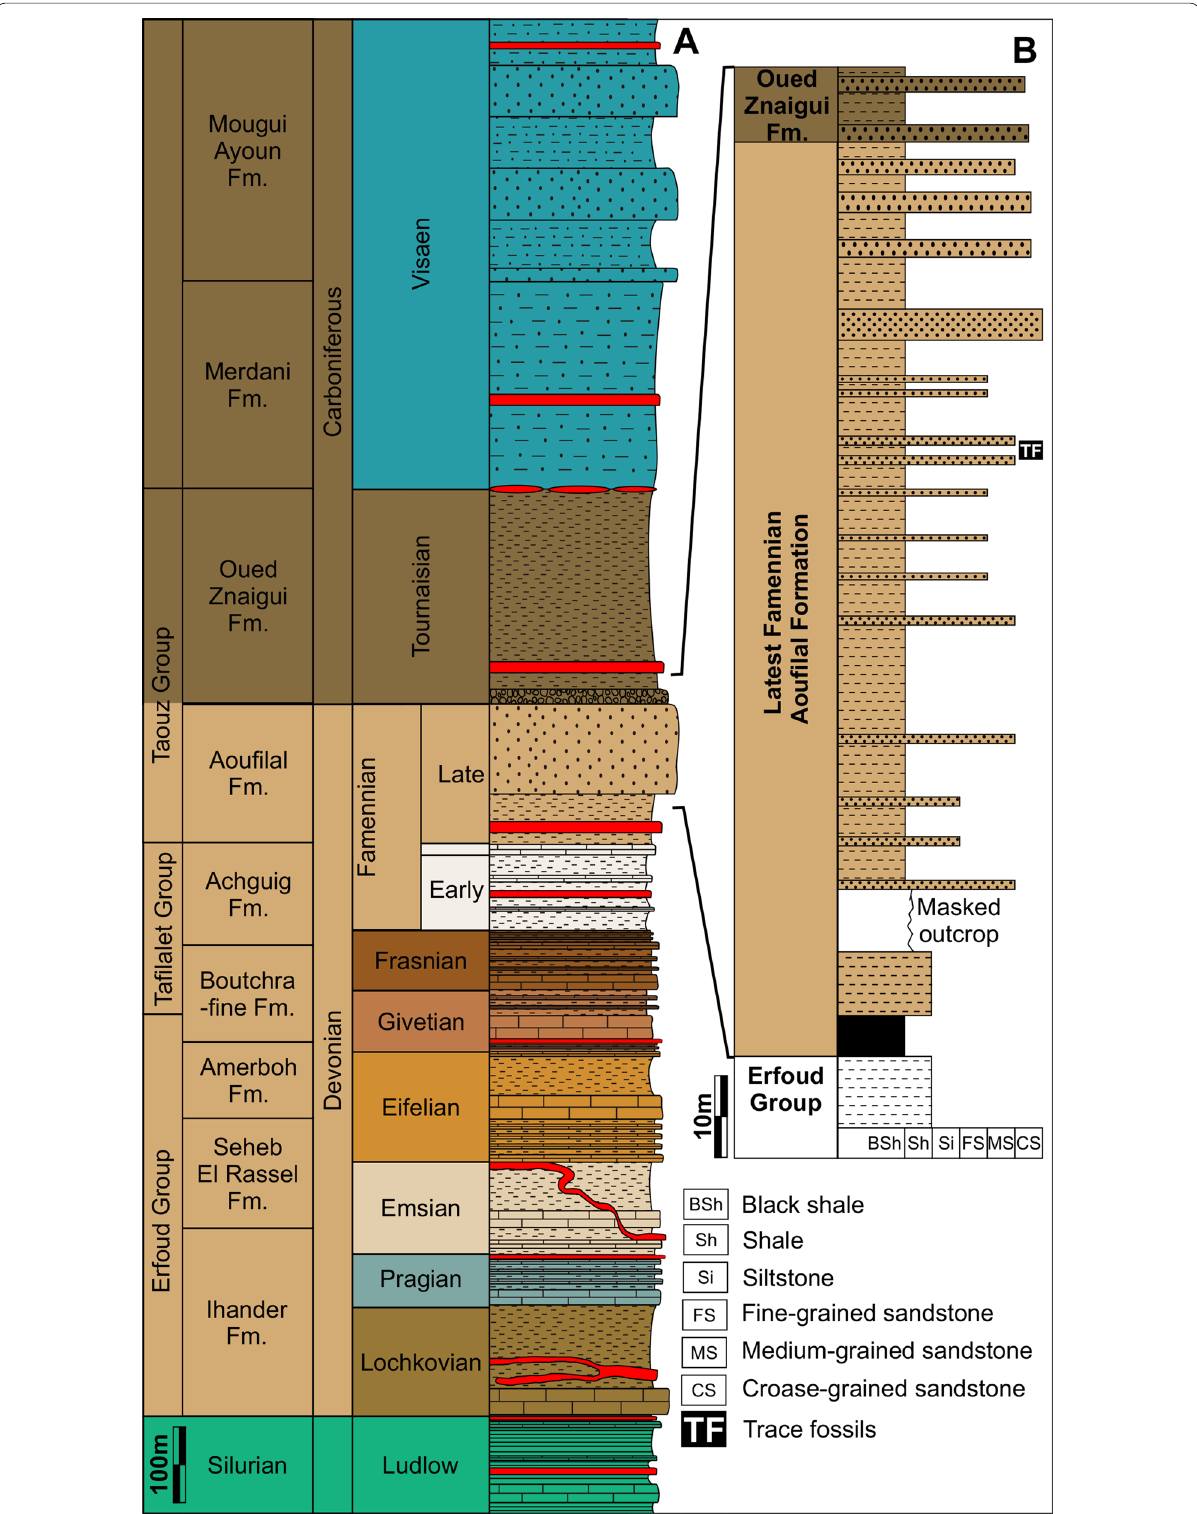
Fig. 2 A Late Paleozoic stratigraphy subdivision of the South Tafilalt region, adapted from Álvaro et al. (2014) and Najih (2019); see more information on the log there. B Lithological section from the Al Atrous region with the stratigraphic position of ichnofossil-bearing